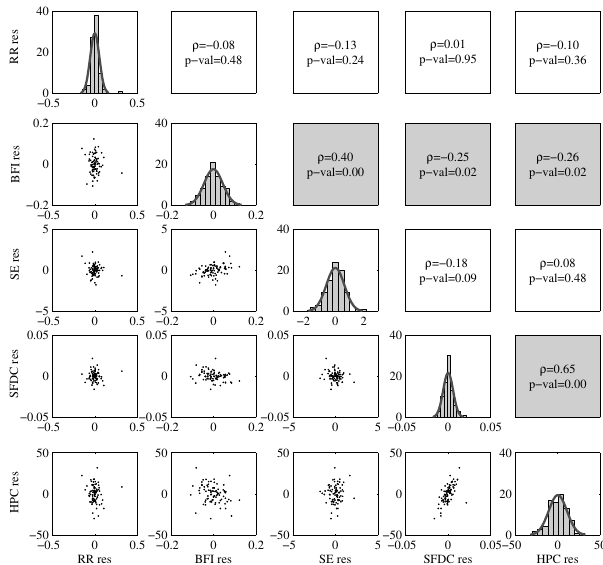
Figure 1. Distribution of individual signature residuals (res) are ap- proximated as histograms and normal distributions. The scatterplots and correlation coefficients ( ρ ) show correlation between the signa- ture